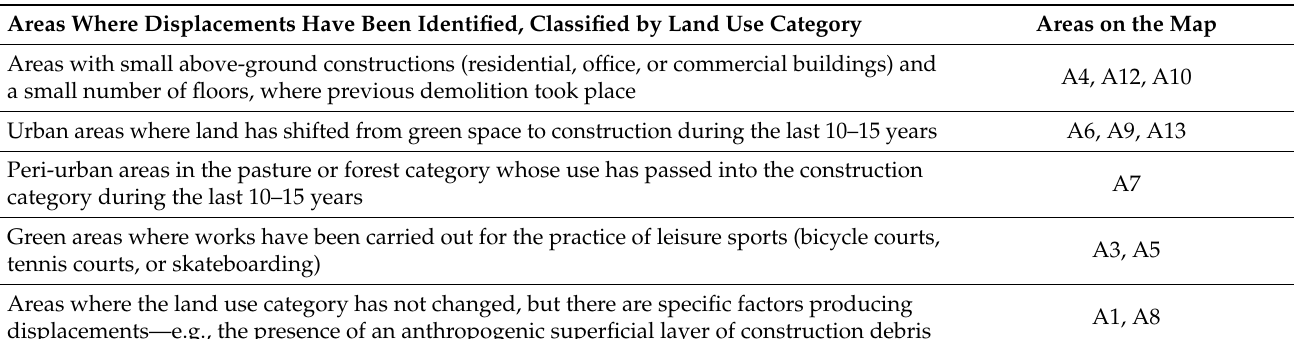
Table 3. Data types and sources (modified after [28]).